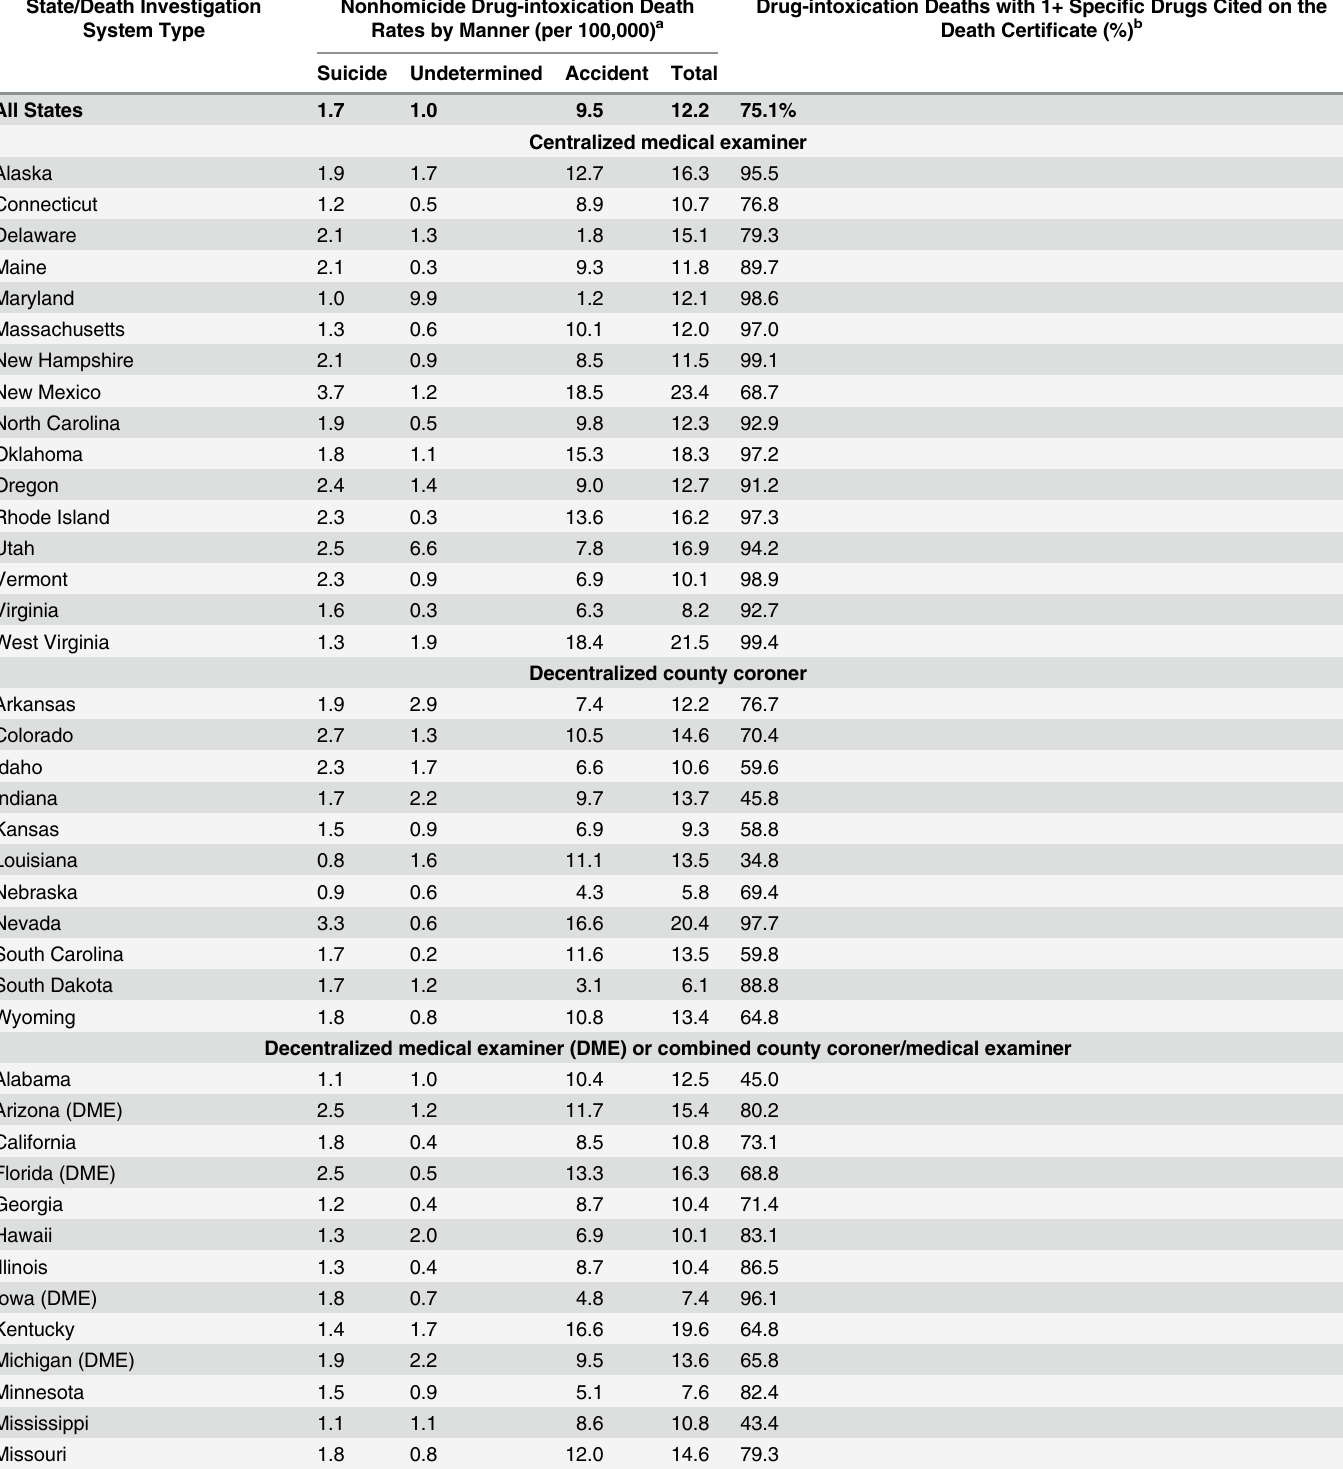
Table 1. Annualized rates for selected cause-specific manners of death and specific drug citation by state/death investigation system type: United States, 2008 –